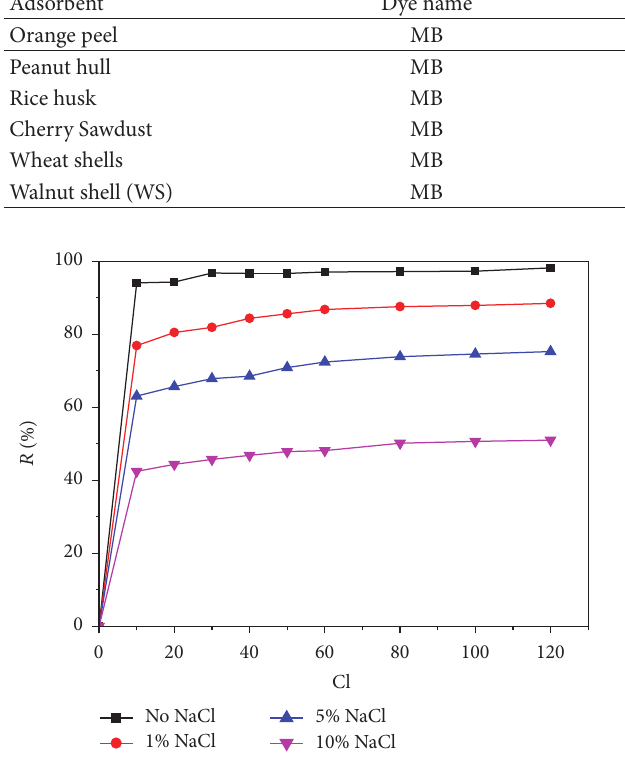
Figure 7: The effect of common salt (NaCl) on the MB removal percentages ( 𝑅